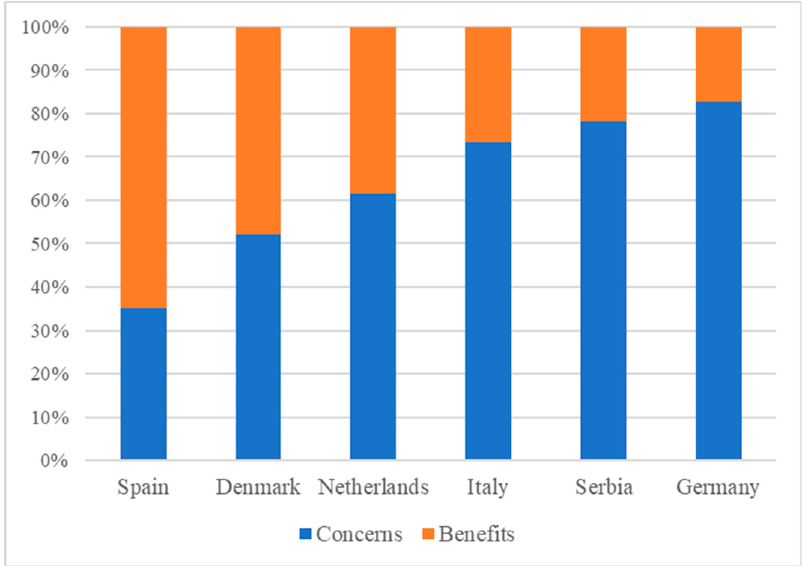
Figure 4. Percentages of concerns and expected benefits stated by participants in different countries.